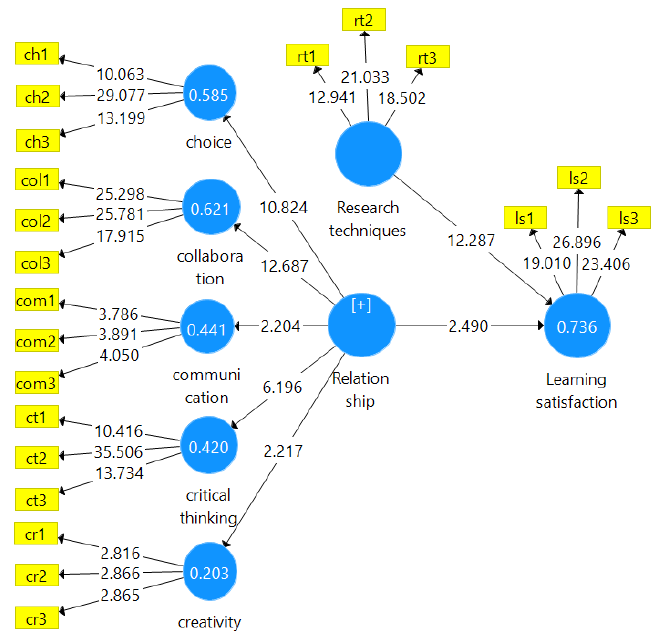
Figure 4. PLS ‐ SEM Hypothesized Model using Bootstrapping. Source: Empirical data analysis by Smart PLS. Smart R ‐ Square (r 2 )